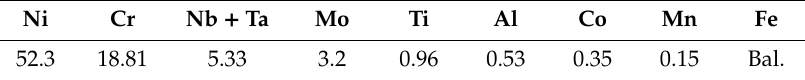
Table 1. Chemical composition of IN718 wire (wt %).